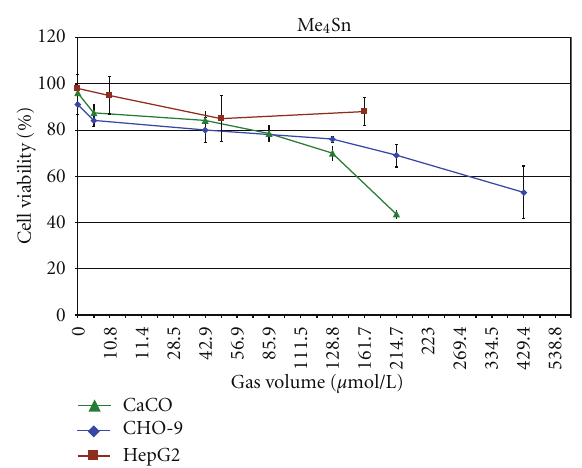
Figure 8: Cytotoxicity of Me 4 Sn in CHO-9, HepG2, and CaCo cells. The experiments were repeated three times.